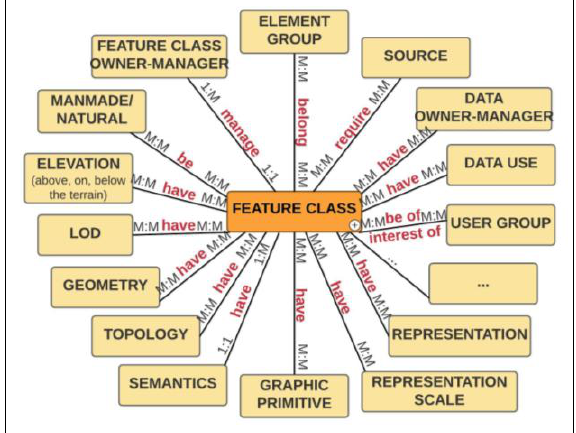
Figure 5: Meta-model for a 3D road cadastre Figure 5 represents the proposed conceptual data model deriving from the table: a meta-diagram starting from the current Road Cadastre structure compared with the technical and social requirements collected and focused on 3D. The majority of the relationships are many:many – e.g. one source is associated with many elements, and an element can be required by more than one source. This approach aims at reflecting the flexibility and multi-use of the model that can also be thought as “a cluster of clusters”. From it a number of physical models reflecting the potential users may be generated, showing how useful each individual element – 3D in particular – is to different